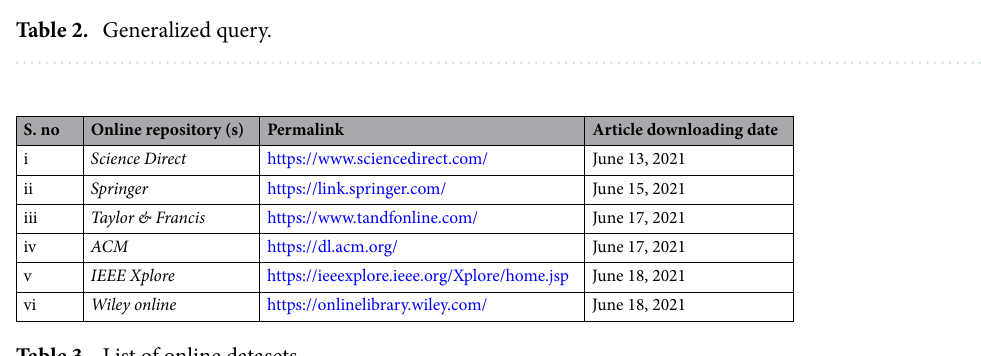
Table 3. List of online